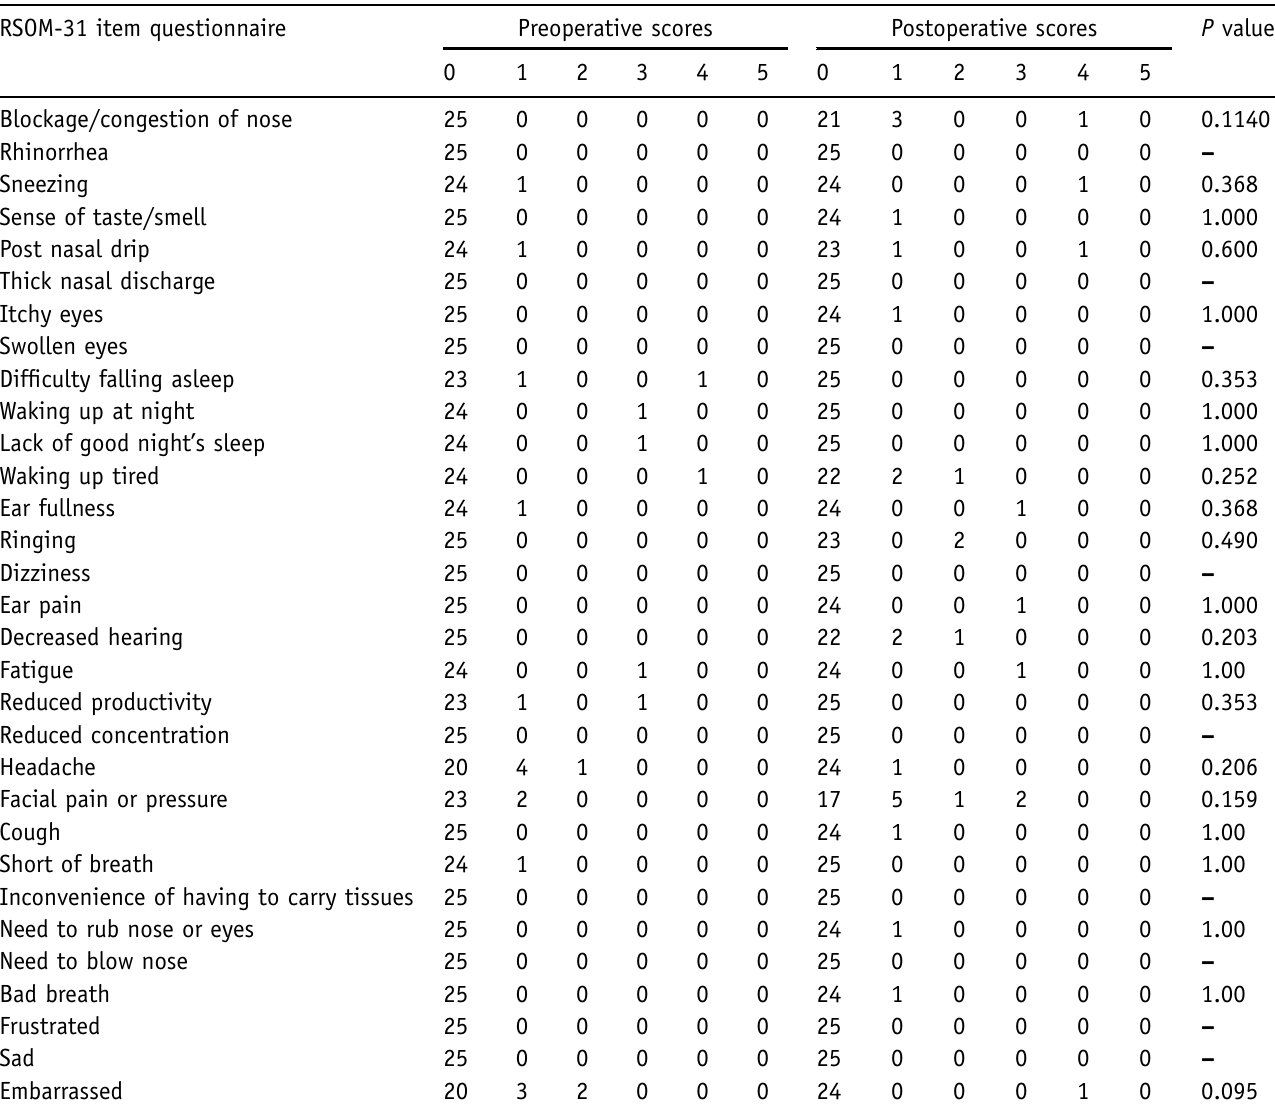
Table II. RSOM-31 questionnaire (chi-square test). RSOM-31 item